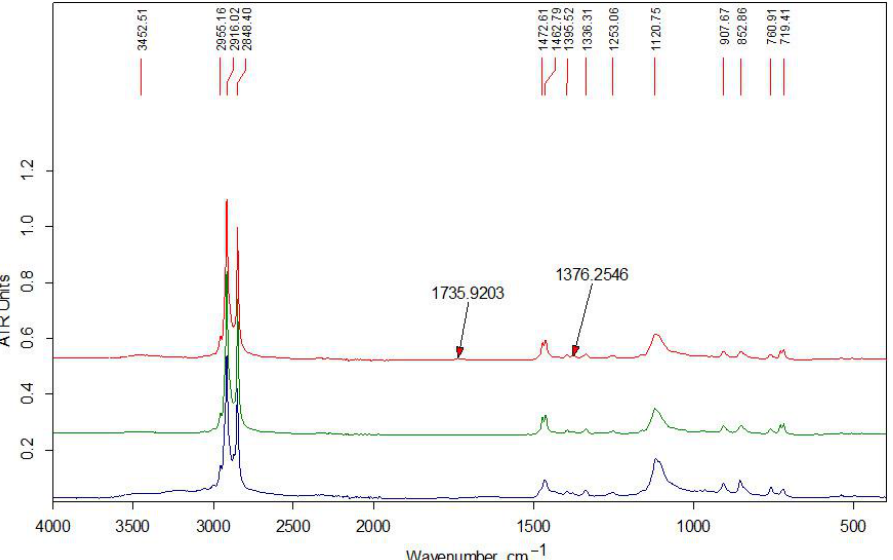
Figure 2. FT-IR spectra (bottom to top): starting reagents HAGE 16 (C16), HAGE 22 (C22); modifier C22 unreacted after co-extrusion.